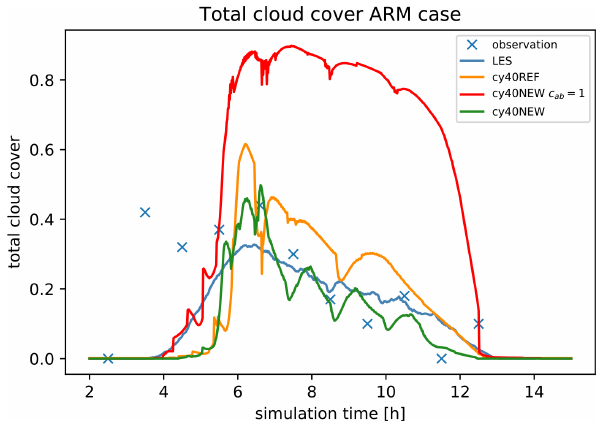
Figure 11. Total cloud cover for the ARM case. Plotted are obser- vations (blue crosses), LES (blue), cy40REF (orange), cy40NEW with c ab = 1 (red; see Eqs. 26, 30, 31), and cy40NEW